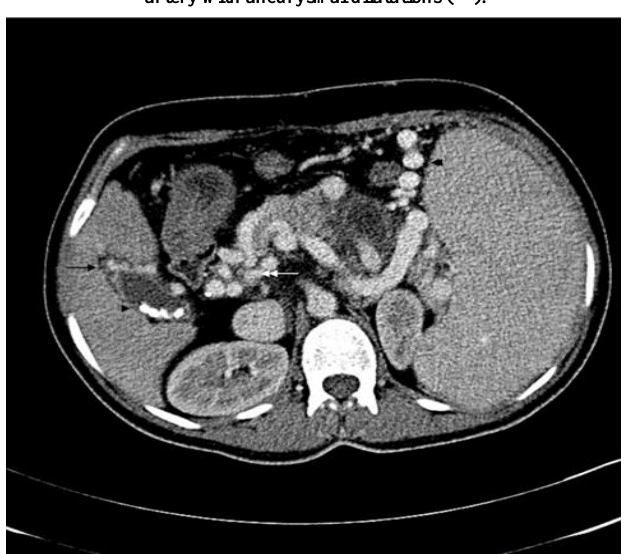
Fig. 5a and 5b. volume-rendered CT Arteriogram images of two patients with extrahepatic portal vein occlusion show tortuous Splenic artery with aneurysmal dilatations ( ← ).